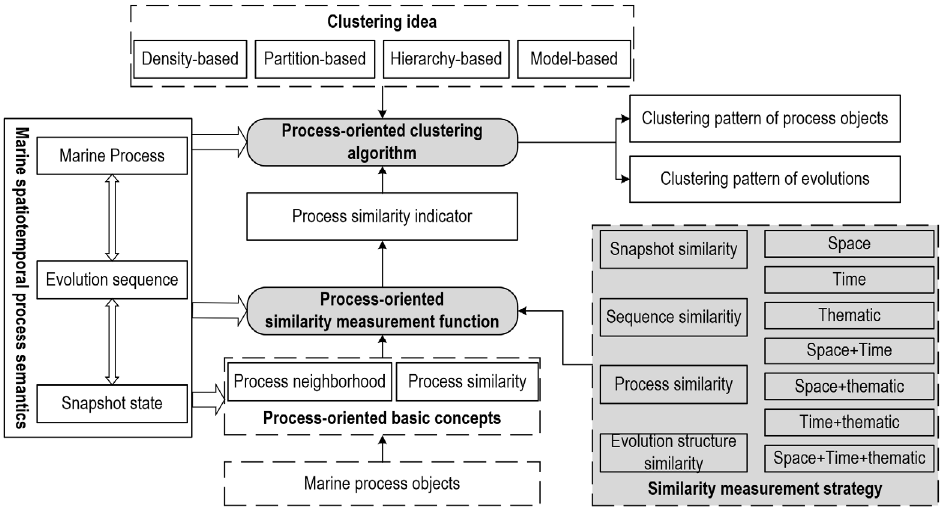
Figure 7. Workflow of process-oriented clustering module.